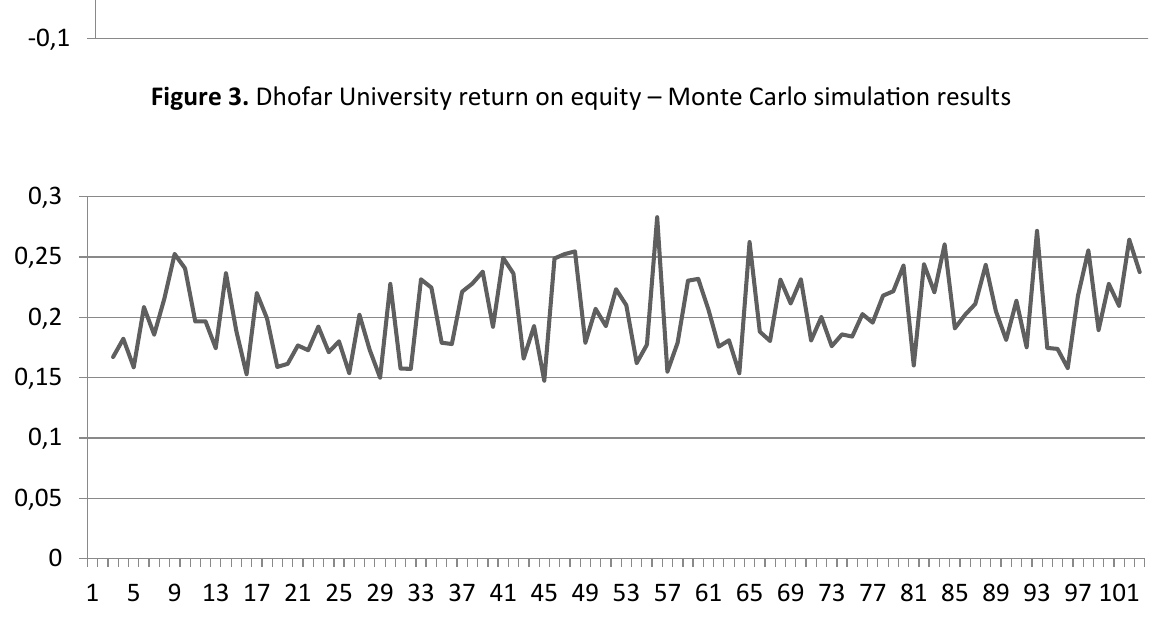
Figure 4. Dhofar University asset turnover ratio – Monte Carlo simulation